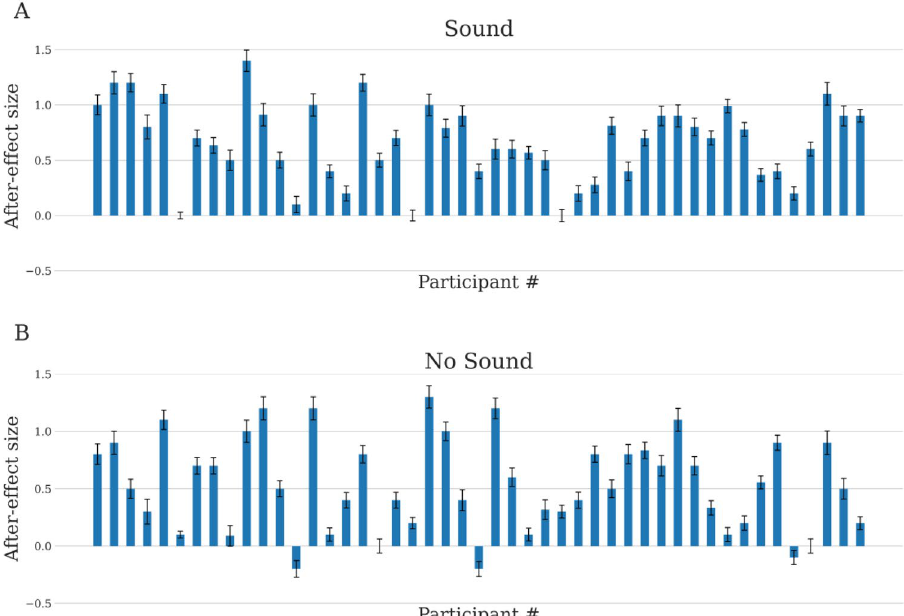
Figure 3. Risk after-effect for the experimental treatment without sound ( A ) and the treatment with sound ( B ). Each bar depicts the after-effect size for one of the participants (N = 47). Like in Payzan-LeNestour, Balleine, Berrada, & Pearson 16 , after-effect size was measured via the difference between the mean reported volatility post low (the reported volatility averaged across the trials in which the participant was exposed to low volatility in adaptation phase) and the mean reported volatility post high (the average reported volatility after exposure to high volatility). Error bars show standard error of the mean (sem).